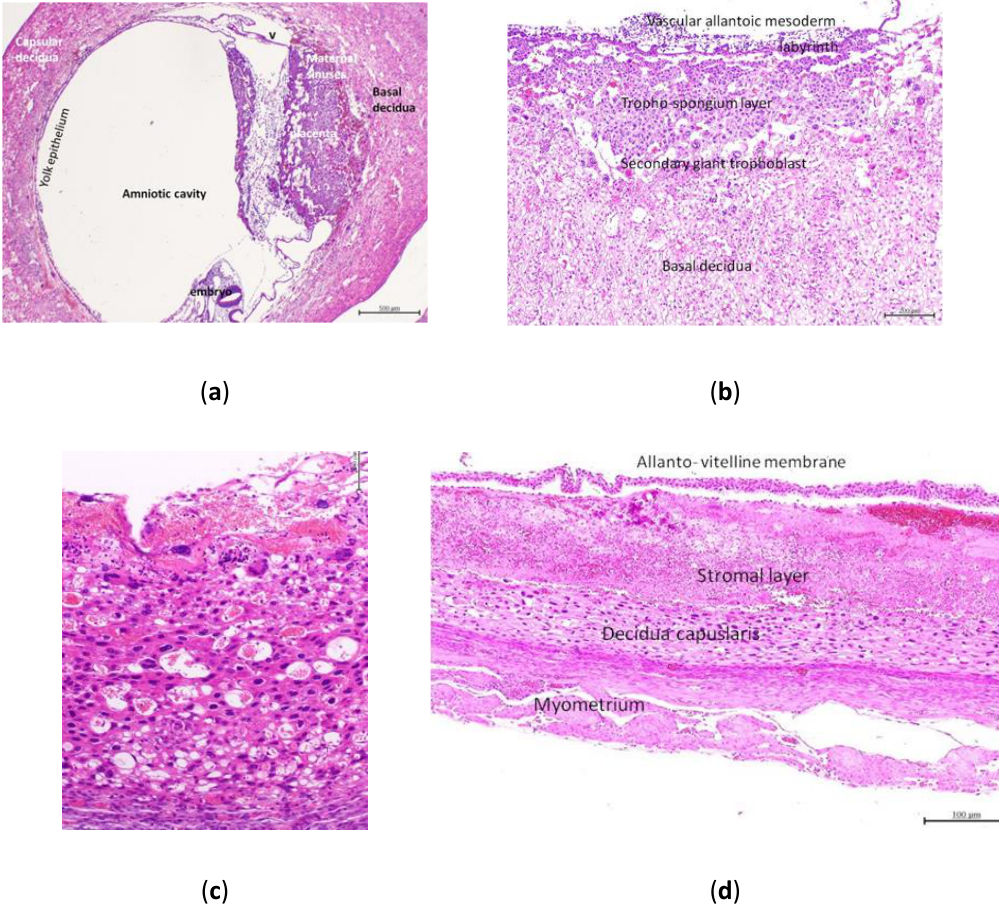
Figure 4. The 8th day of gestation in the control group: the placentation cone composed of the implantation site, basal decidua, and capsular decidua ( a ). The implantation site composed of vascular allantoic mesoderm, labyrinth, trophospongium layer, secondary giant trophoblasts, and basal decidua ( b ). The capsular placentation (yolk sac placentation) composed of yolk sac epithelium, secondary giant trophoblasts, and capsular decidua ( c ). Cross section through the capsular placentation and myometrium revealed allanto-vitelline membrane, stromal layer, decidua capsularis and myometrium ( d ).